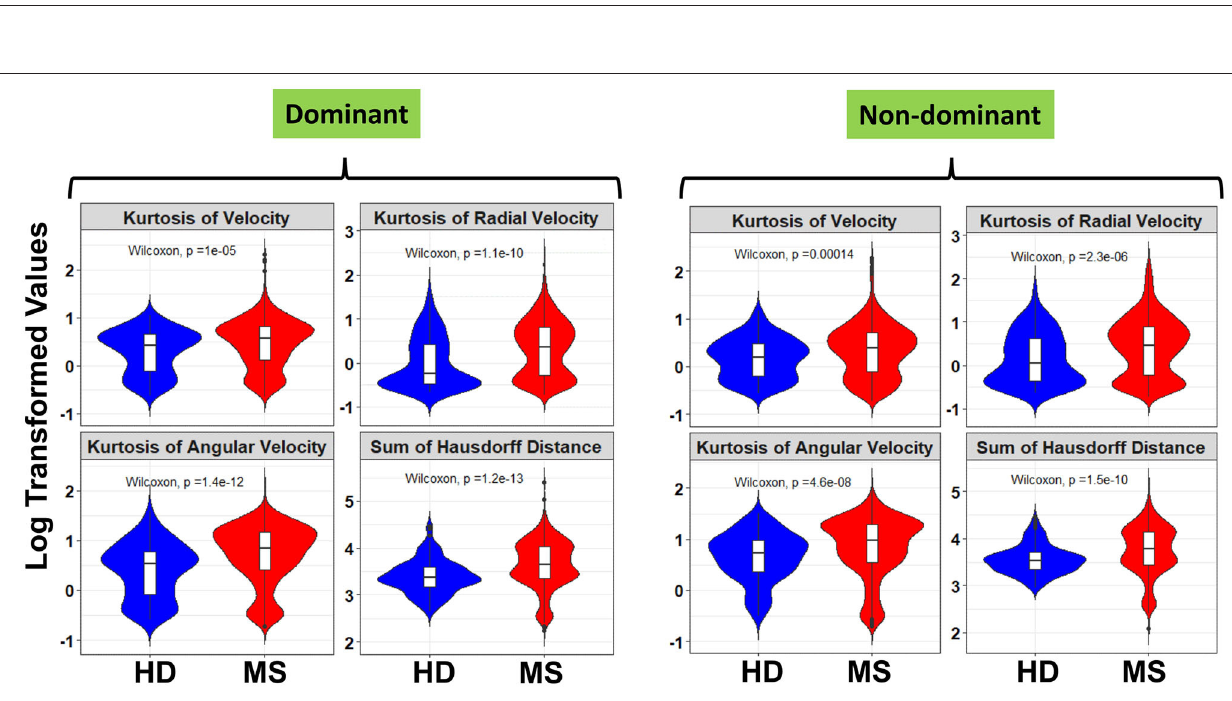
Frontiers in Medical Technology |